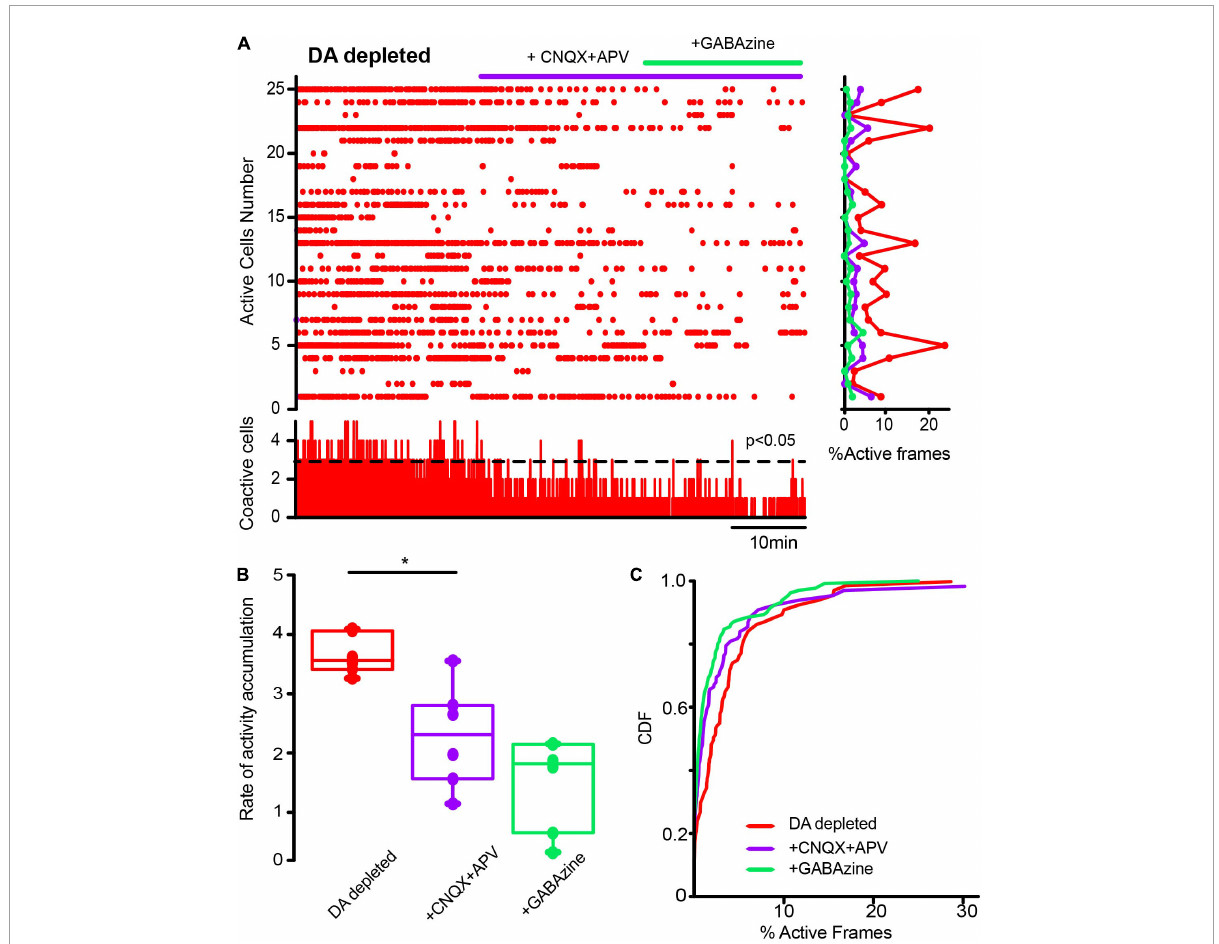
FIGURE8 Glutamatergic inputs to the striatal microcircuit are essential for the activity increase in cholinergic interneurons in dopamine-depleted tissue. (A) The raster plot represents the activity of identified CINs recorded simultaneously in DA-depleted tissue, before and after applying glutamatergic antagonists (10 µ M CNQX and 50 µ M APV) and the GABAergic antagonist (10 µ M GABAzine). Both cell activities (right: rows) and significant coactivity peaks (bottom) are decreased. (B) Box plots show significant reductions in the rate of activity accumulation after the antagonists (* P = 0.03; Wilcoxon T -test: DA-depleted vs. DA depleted with glutamatergic antagonists). Subsequent application of GABAzine appears to further reduce the rate of activity accumulation, but this is non-significant. (C) Cumulative distribution functions (CDFs) of ChAT+ neurons: DA-depleted CINs vs. CINs plus CNQX + APV ( P < 0.0001); with further addition of GABAzine ( P < 0.0001; Kolmogorov-Smirnov test; n-DA-depleted CINs = 159 neurons; with CNQX + APV = 145 neurons; plus GABAzine = 143 neurons from n = 6 slices from 6 different